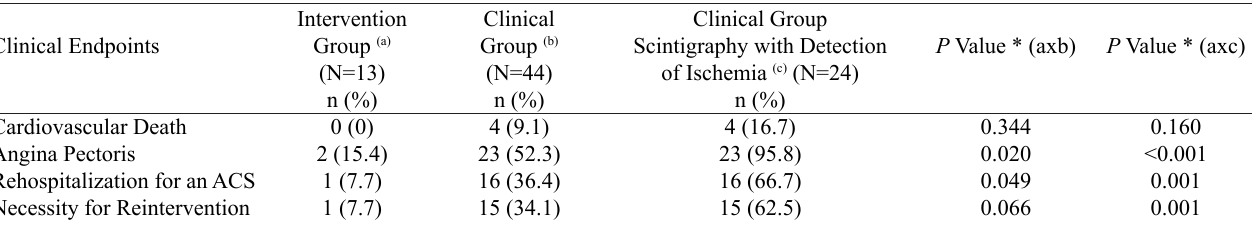
Table 3. Clinical endpoints in the 2-year follow-up of patients who underwent primary PCI only in the culprit lesion associated with the STEMI. Clinical